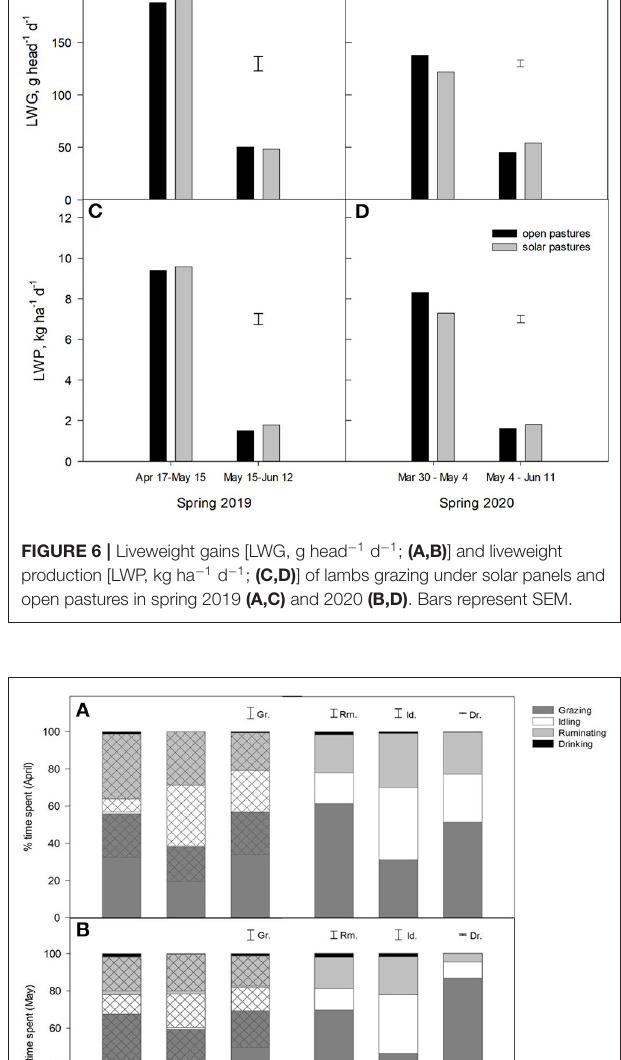
FIGURE 7 | Lamb foraging behavior in open and solar pastures in April (A) and May 2020 (B) . Crosshatch represents the time spent under full shade. Bars represent SEM. Gr = grazing, Rm = ruminating, Id = idling, Dr = drinking. solar panels was similar in May (46.5%). However, there was a difference in time of the day that they spent grazing activities under solar panels. While, they also undertook over 50% of their grazing activity in shade as well in the morning and noon the lambs spent only 29% of their grazing time under solar panels in the